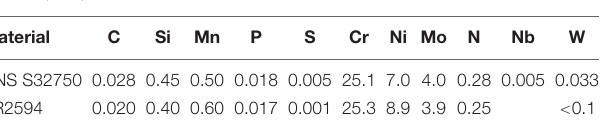
TABLE 1 | Chemical compositions of the base metal and filter wire in mass percent